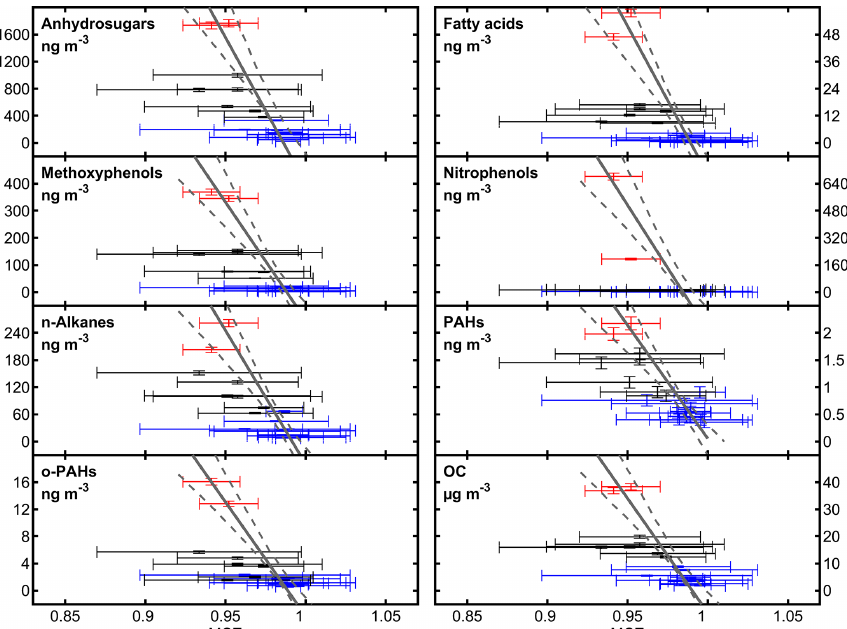
Figure 8. Relation between modified combustion efficiency (MCE) and various compound classes. Blue, black, and red colors correspond to the periods of low, medium, and high BB influence, respectively. Error bars illustrate the uncertainty of each data point (please note that uncertainties for concentrations are partly too small to be visible in the figure). The gray lines refer to linear fits from Deming regression. Dashed lines denote the non-simultaneous prediction band of the fit function by means of 1 σ